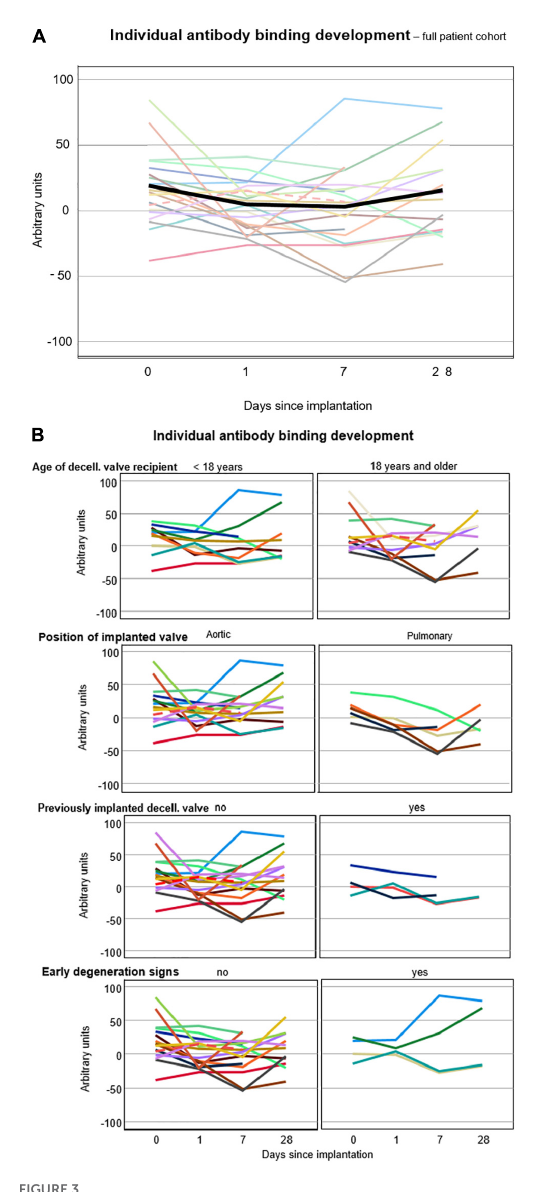
FIGURE2 (A) Correlation of baseline antibody binding in patients who had received decellularized allografts according to donor age. (B) Antibody binding in patients with and without a sex mismatch to the DHV donor. (C) Antibody binding in patients differentiated by recipient blood group.